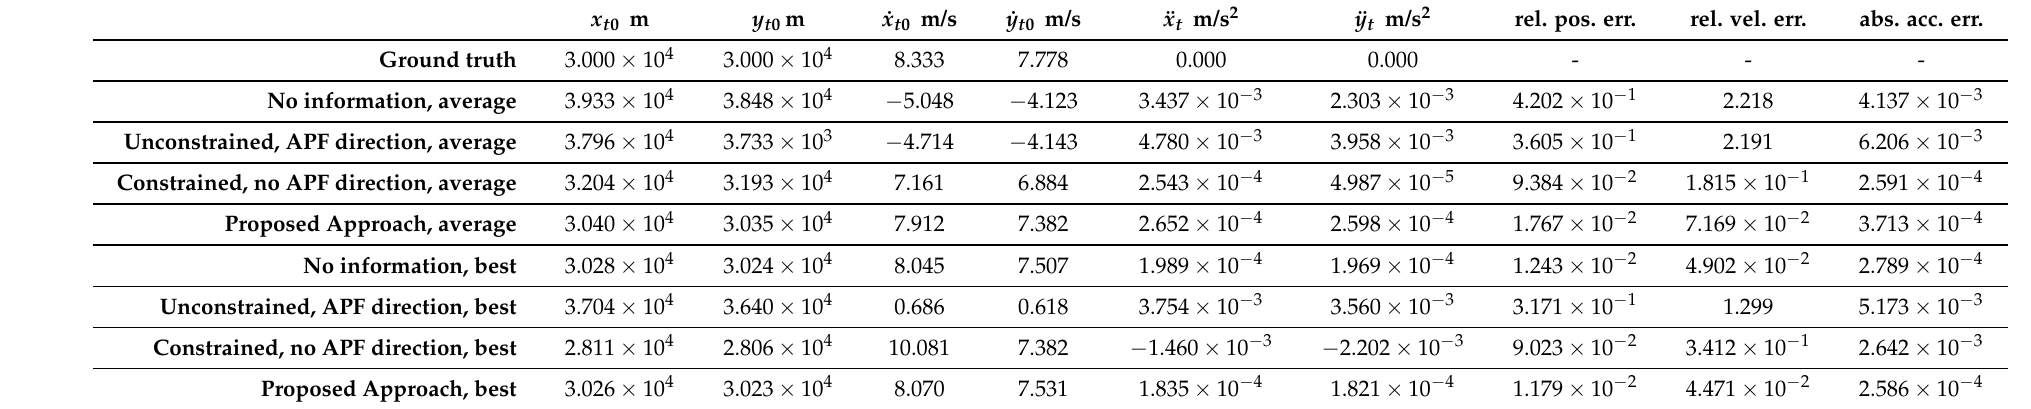
Table 2. MLE parameter estimation via MIDACO-SOLVER for the different operational